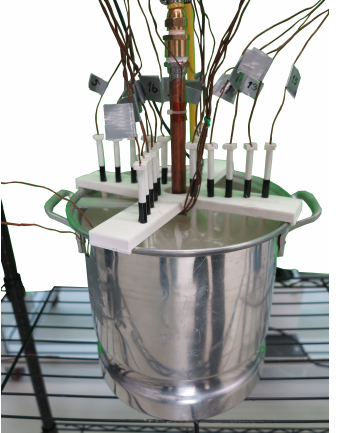
Figure 4. Cylindrical unit with thermocouple array for temperature